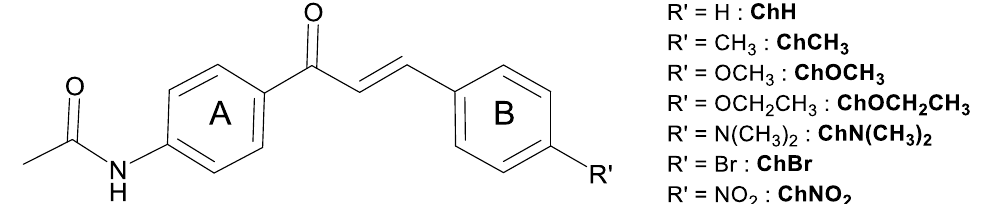
Figure 1. Molecular structure of the compounds studied. R’ represents the position of different sub-